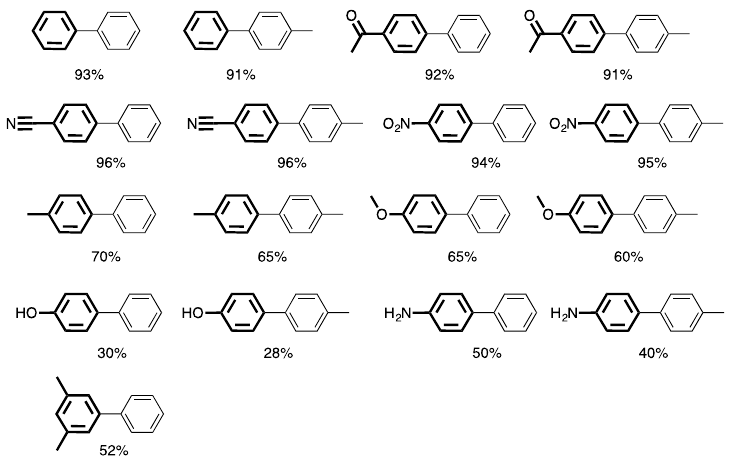
Figure 6. Substrate scope of continuous flow Suzuki–Miyaura cross-coupling sequence using Pd dendrimers encapsulated microreactor.